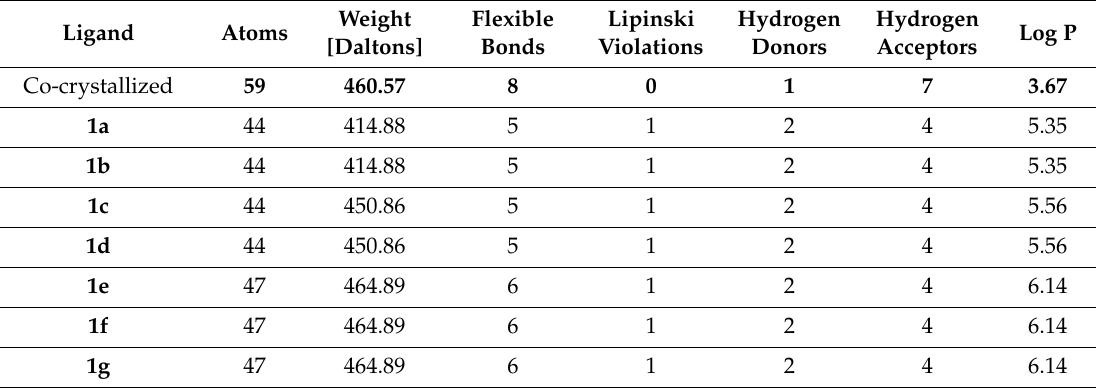
Table 3. Calculated properties of ligands properties with CLC Drug Discovery Workbench Software. Ligand Atoms